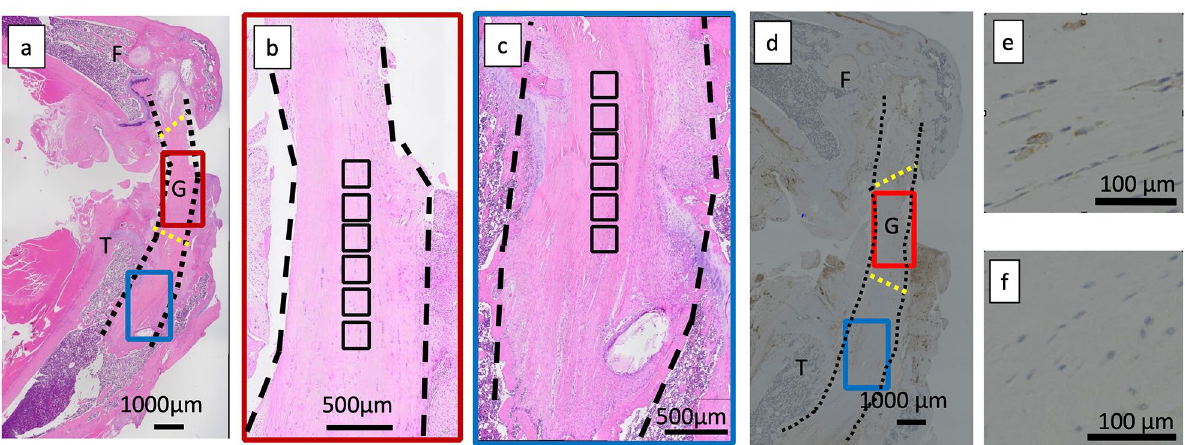
Figure 8. Hematoxylin–eosin staining and immunohistological staining of M1 and M2 macrophages in the femur–graft–tibia complex for quantitative evaluation of cells infiltrated into the decellularized and autologous grafts. ( a ) Overall view of the femur–graft–tibia complex stained with hematoxylin–eosin. ( b ) Magnified view of the intra-articular graft, magnifying the red rectangle in Fig. 7a. ( c ) Magnified view of the graft in the tibial tunnel, magnifying the blue rectangle in Fig. 7a. ( d ) Overall view of the immunohistological staining of M1 and M2 macrophages in the femur–graft–tibia complex. M1 and M2 macrophages in the intra-articular graft (red rectangle) and intratibial tunnel graft (blue rectangle) were counted using the same method used for counting cells observed via hematoxylin–eosin staining. ( e ) M1 macrophages. ( f ) M2 macrophages. The black dashed line shows the surface of the graft. The aperture of the bone tunnel into the joint is indicated by the yellow dashed line. One black square in Fig. 7b,c has a surface area of 200 µm 2 . The cells in six 200-µm 2 square regions were counted using the ImageJ software (ImageJ, version 1.50i, https:// imagej. nih. gov/ ij/). F femur, G graft, T